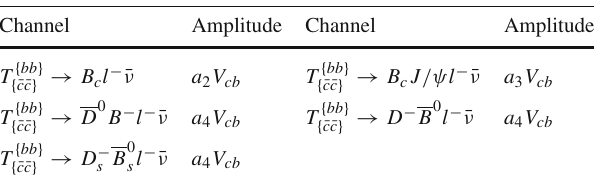
{ bb } {¯ c ¯ c } decays into two mesons and